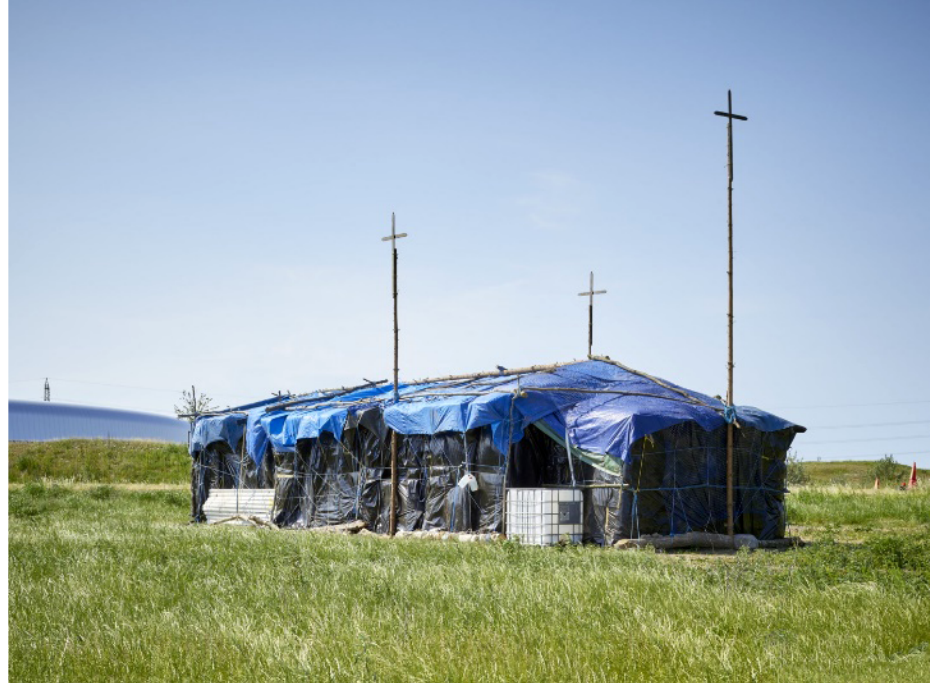
Figure 5. And We Are Everywhere, by Nathan Coley, Lund 2018–2019. Source: Peter Westrup. relationship to immigration, people with no